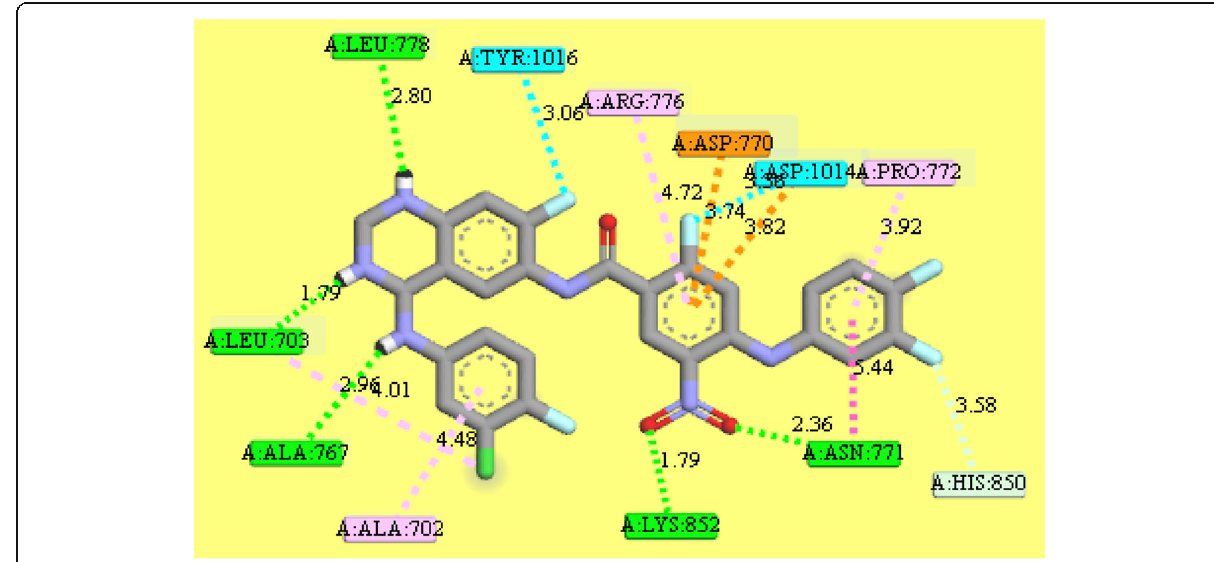
Fig. 7 2D structures of the SDD4 receptor using discovery studio